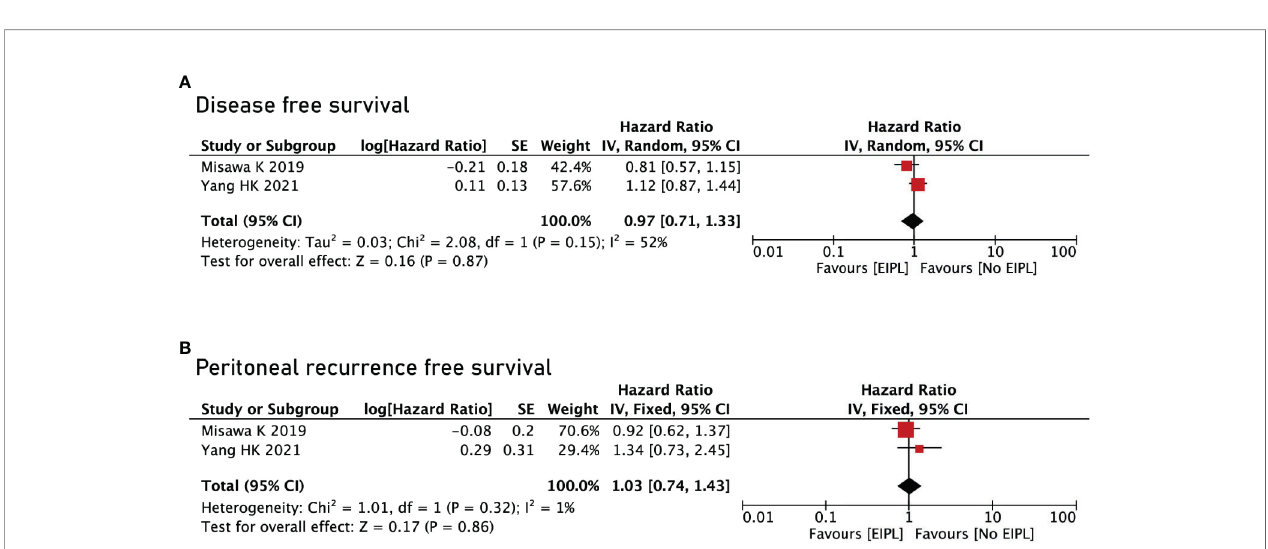
FIGURE 5 | Disease-free survival and peritoneal recurrence – free survival between EIPL group and No EIPL group. (A) Disease-free survival. (B) Peritoneal recurrence – free survival. EIPL, extended intraoperative peritoneal